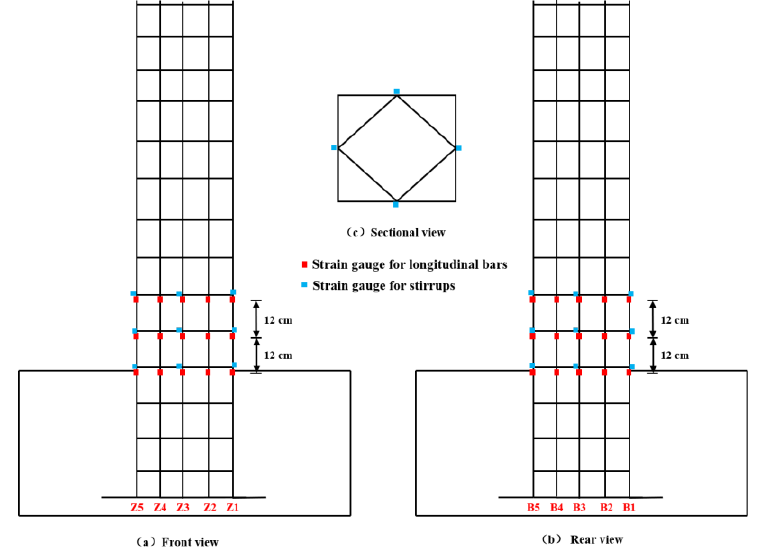
Figure 6. Setup of strain measurement at the plastic hinge region of bridge pier.